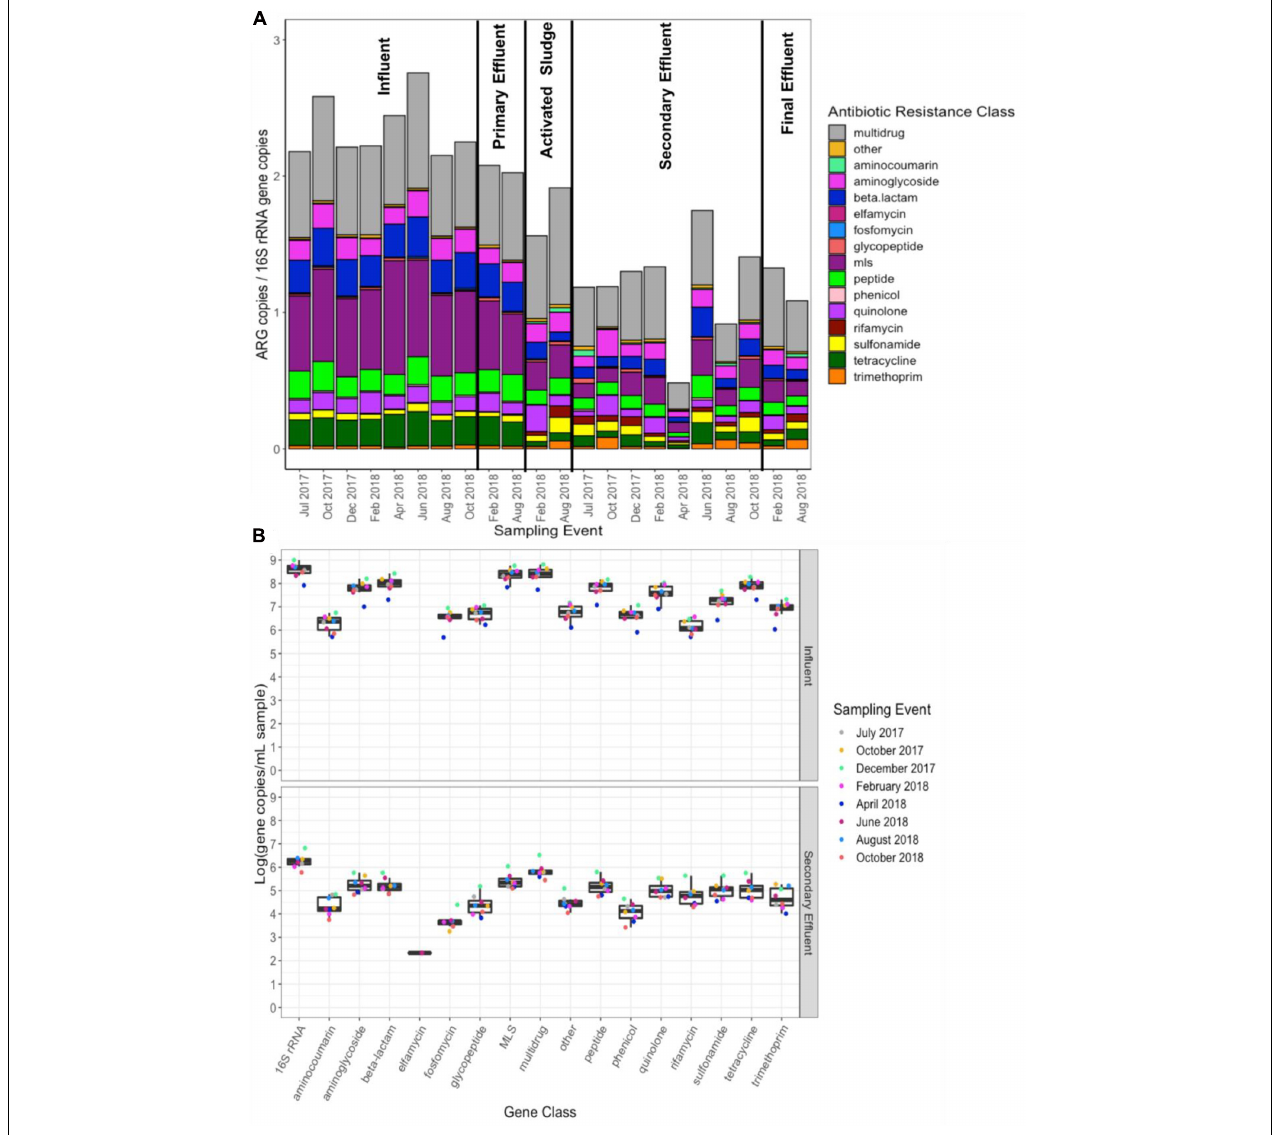
FIGURE 1 | (A) Total ARG (i.e., all ARGs detected) relative abundance [copies per copies of 16S rRNA normalized as previously described (Li et al., 2015)], grouped by antibiotic resistance class, across all 22 samples subject to shotgun metagenomic sequencing and (B) calculated absolute abundance (units: log 10